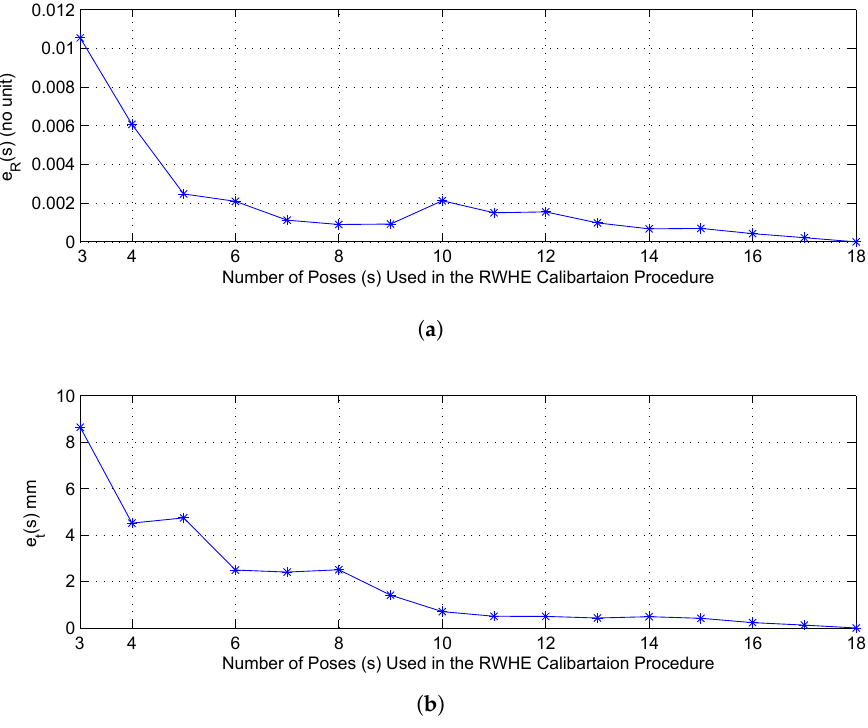
Figure 6. The accuracy of the extrinsic camera calibration parameters as a function of the number of poses used in the RWHE calibration procedure for configuration 2: ( a ) rotation error of the estimated Z matrix; ( b ) translation error of the estimated Z matrix.